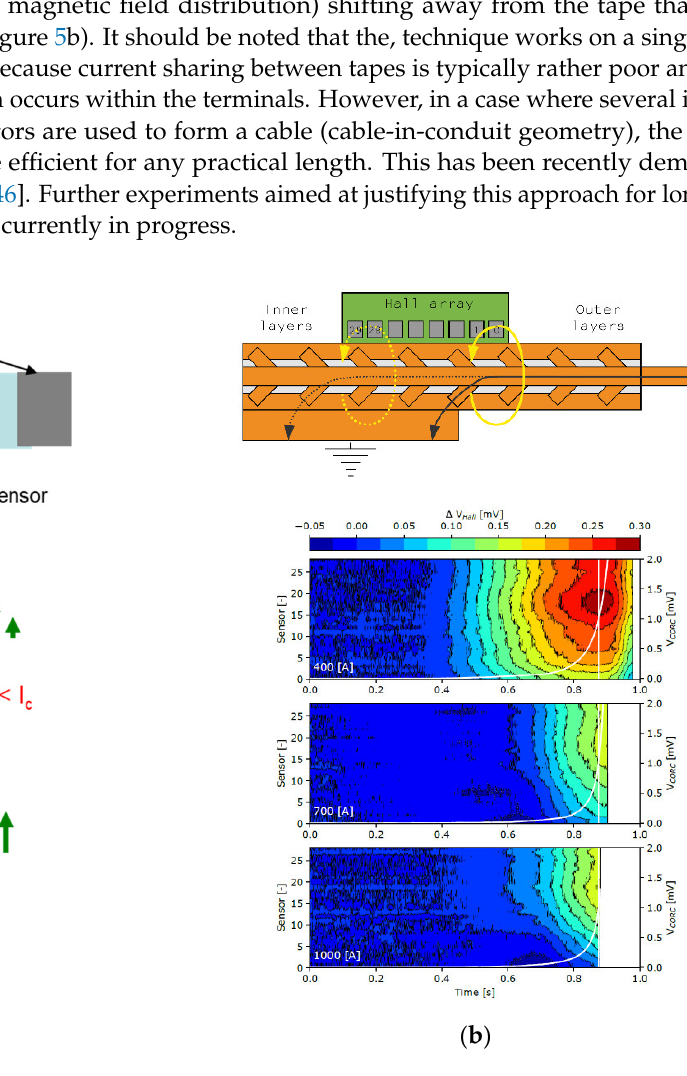
Figure 5. ( a ) A sketch illustrating the principle of Hall sensor-based quench detection. A Hall sensor placed in the gap between two ReBCO conductors can detect onset of the normal zone in one of those by measuring field imbalance (adopted from [44]). ( b ) A practical implementation of same technique in a form of a Hall array embedded in the current terminals of the CORC ® cable. Quench onset is detected through a local redistribution of current flow inside the terminal (adopted from [45]).